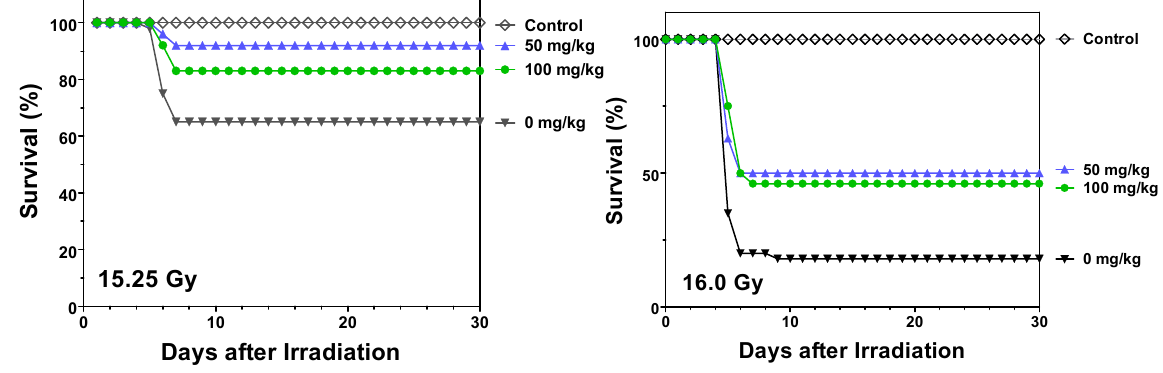
Figure 6. Post-radiation treatment with multiple-dose opaganib improves survival of partially shielded irradiated mice. C57BL/6 mice were orally treated with 0 ( ▼ ), 50 ( ▲ ) or 100 ( ● ) mg/kg opaganib 24 h after being exposed to 15.25 ( Left Panel ) or 16.0 ( Right Panerl ) Gy irradiation with 5% bone marrow shielding. Control mice did not receive opaganib or radiation ( ♦ ). Mice were treated with opaganib twice daily at the same dose as their initial treatment for a total of 3 days after radiation. Mice were monitored for survival for 30 days.